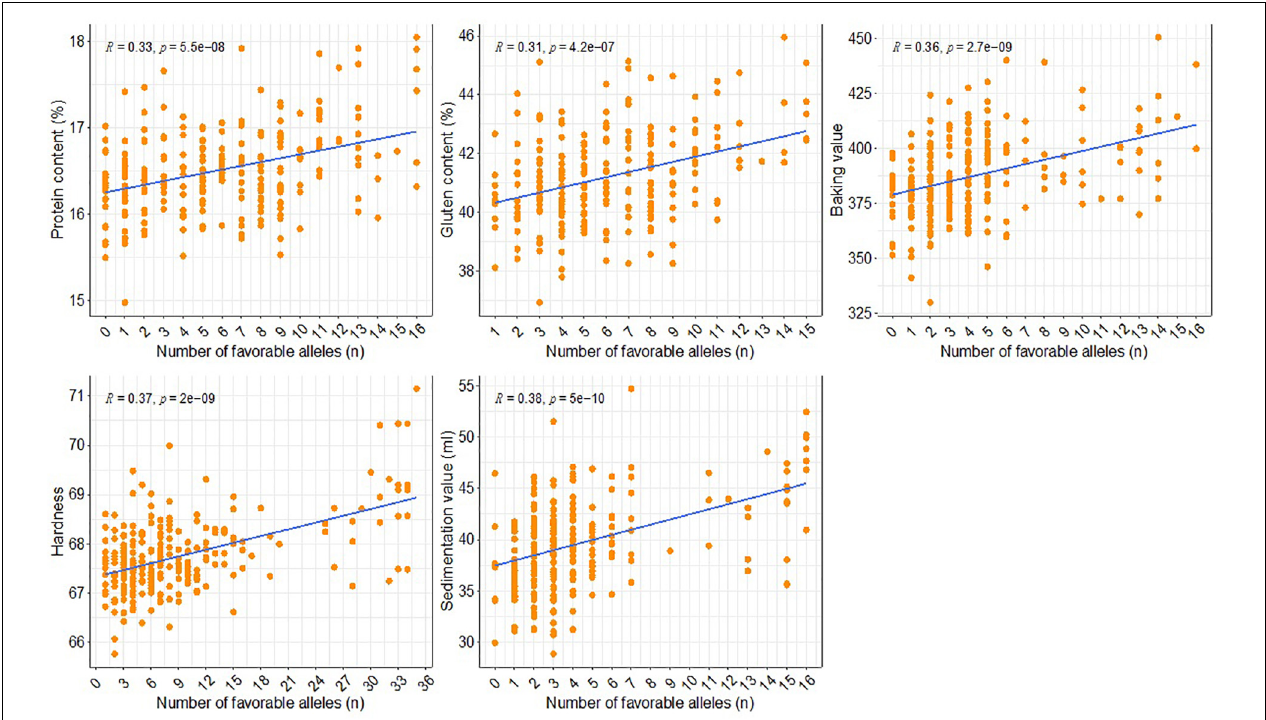
FIGURE 5 | Distribution of the favorable alleles of the stable QTL in the association panel and their effects on five quality traits.